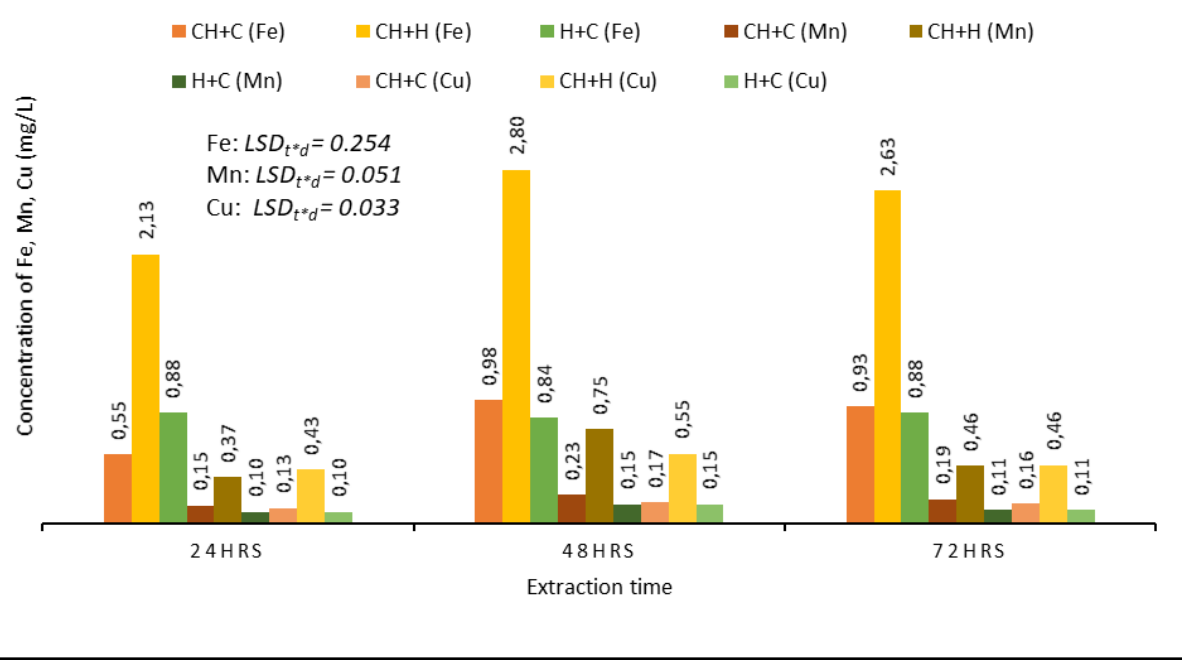
Figure 4. Determination of iron, manganese, and copper in different vermicompost teas over 72-h extraction period.